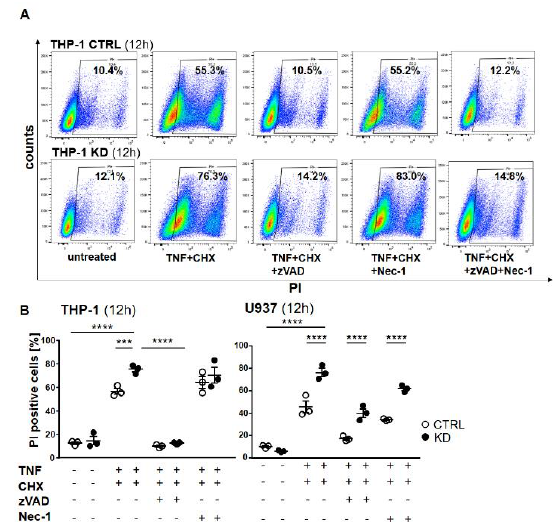
Figure 6. Cell death was rescued using the pan-caspase inhibitor zVAD-fmk (ZVAD). ( A ) THP-1 cells were pretreated with zVAD and/or necrostatin-1 (Nec-1) for 1 h and treated with TNF and CHX overnight. The cells were harvested, stained with propidium iodide (PI), and analyzed by flow cytometry. The percentage of dead cells following treatment is indicated. ( B ) Graphs representing flow cytometry analysis of THP-1 (left panel) and U937 (right panel). Error bars specify the standard error mean (SEM) of at least three experiments. Statistical significance was calculated by two-way ANOVA with Bonferroni post hoc test, n = 3. Data represent the mean ± SEM. *** p ≤ 0.001, **** p ≤